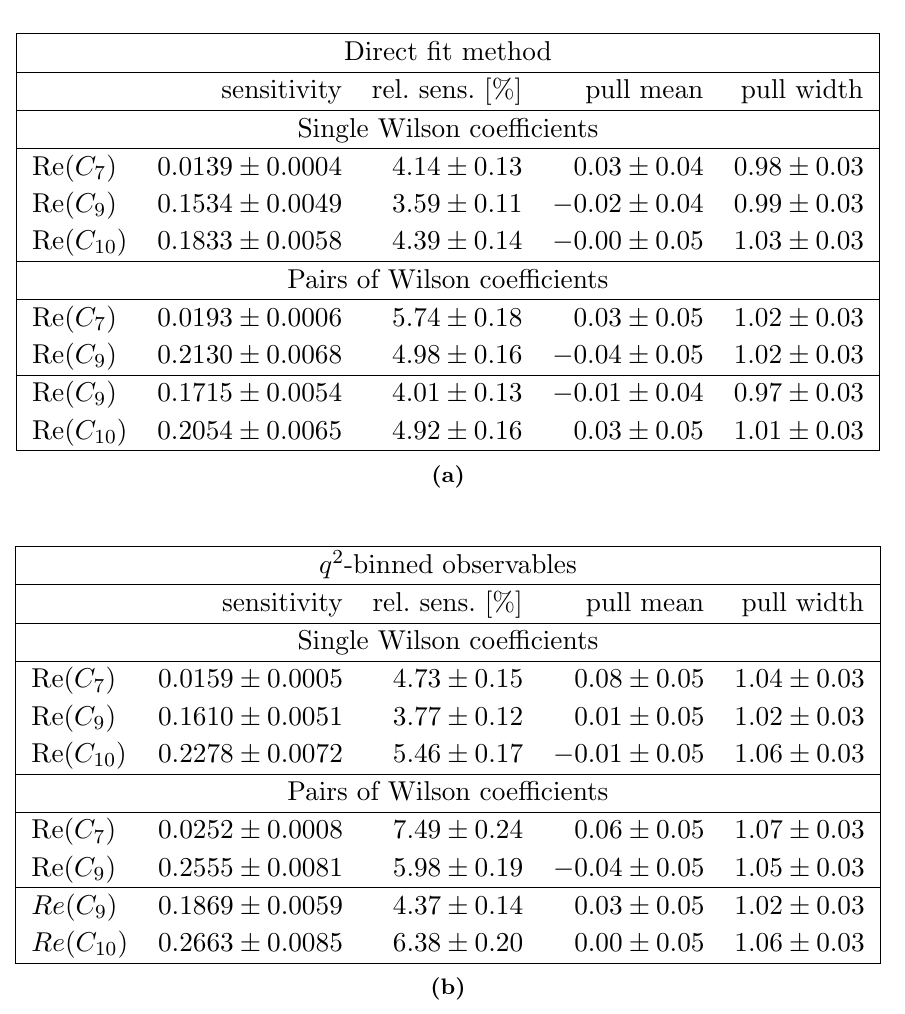
Table 3. Summary of the sensitivity to the Wilson coe(cid:14)cients (absolute and relative to the SM value of the Wilson coe(cid:14)cient) as well as the means and widths of the pull distributions for (a) the direct (cid:12)t method and (b) the conventional q 2 -binned